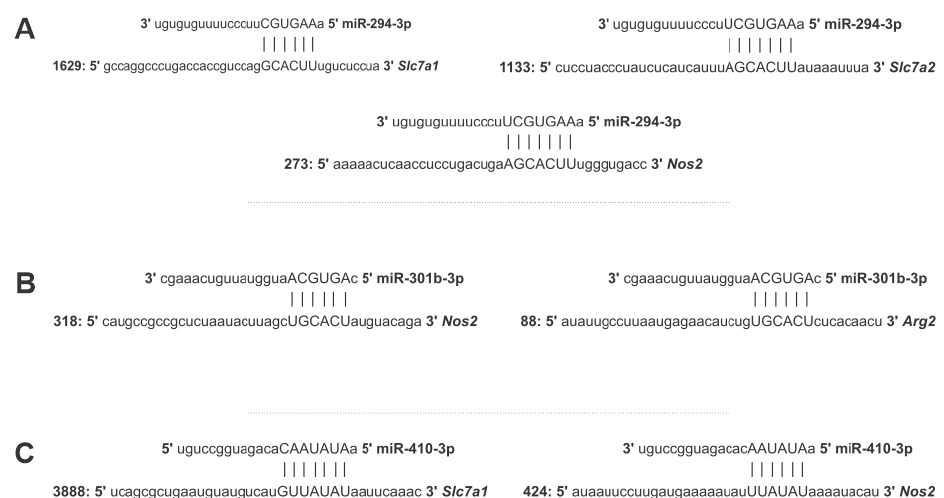
Figure 2. In silico microRNA binding prediction in the 3 ′ UTR region of genes involved in L-arginine metabolism. The search for the prediction of miRNA target repression of genes Nos 2, Slc 7 a 1, Slc 7 a 2, and Arg 2 using miRmap (https://mirmap.ezlab.org/ accessed on 28 August 2020) [35]; selecting the Mus musculus species and mRNAs and setting the combination of ∆ G open > 9 (mRNA opening free energy), exact probability > 60 (exact distribution of site over-representation probability), and miRmap score > 60; and identified the binding of ( A ) miR-294-3p, ( B ) miR-301b-3p, and ( C ) miR-410-3p.